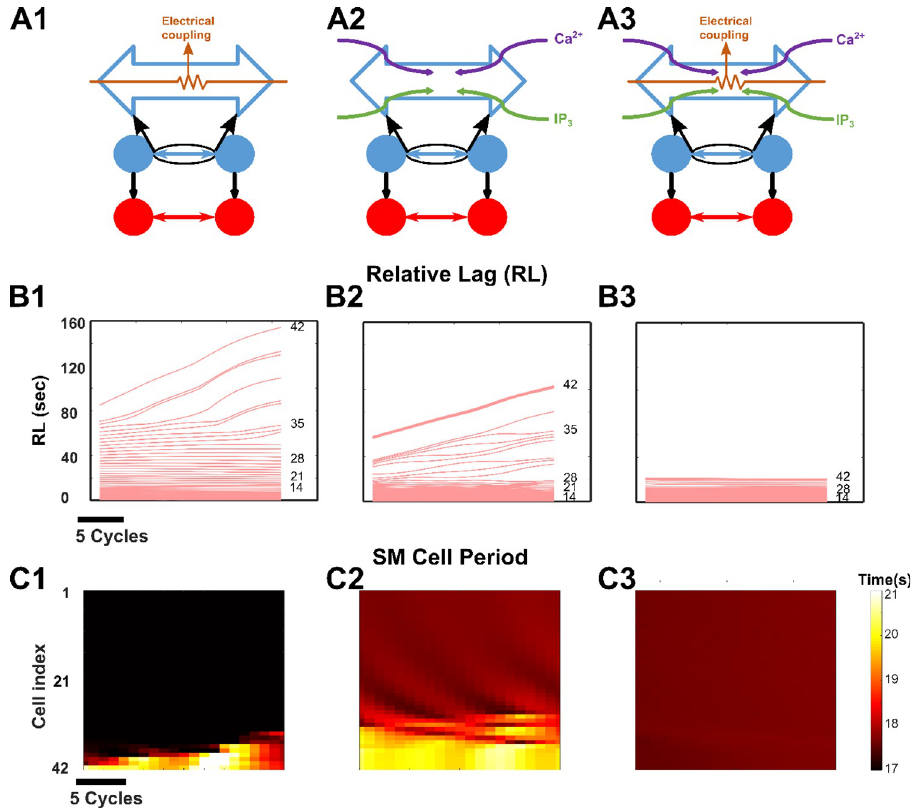
Fig 4. Enhanced longitudinal entrainment. Synergy of electrical coupling and second messenger exchange preserve longitudinal entrainment along the entire length of the stomach. (A1, A2 and A3) Structure of the network, when only electrical coupling is present (A1) , when only exchange of second messengers is present (A2), and when both electrical coupling and exchange of second messengers are present (A3) . (B) The Relative Lags for the three different cases shown in Fig 4A are measured from the last 20 cycles of respective simulations. (C) Spatiotemporal maps of SM Cell Periods in the three different cases respectively.